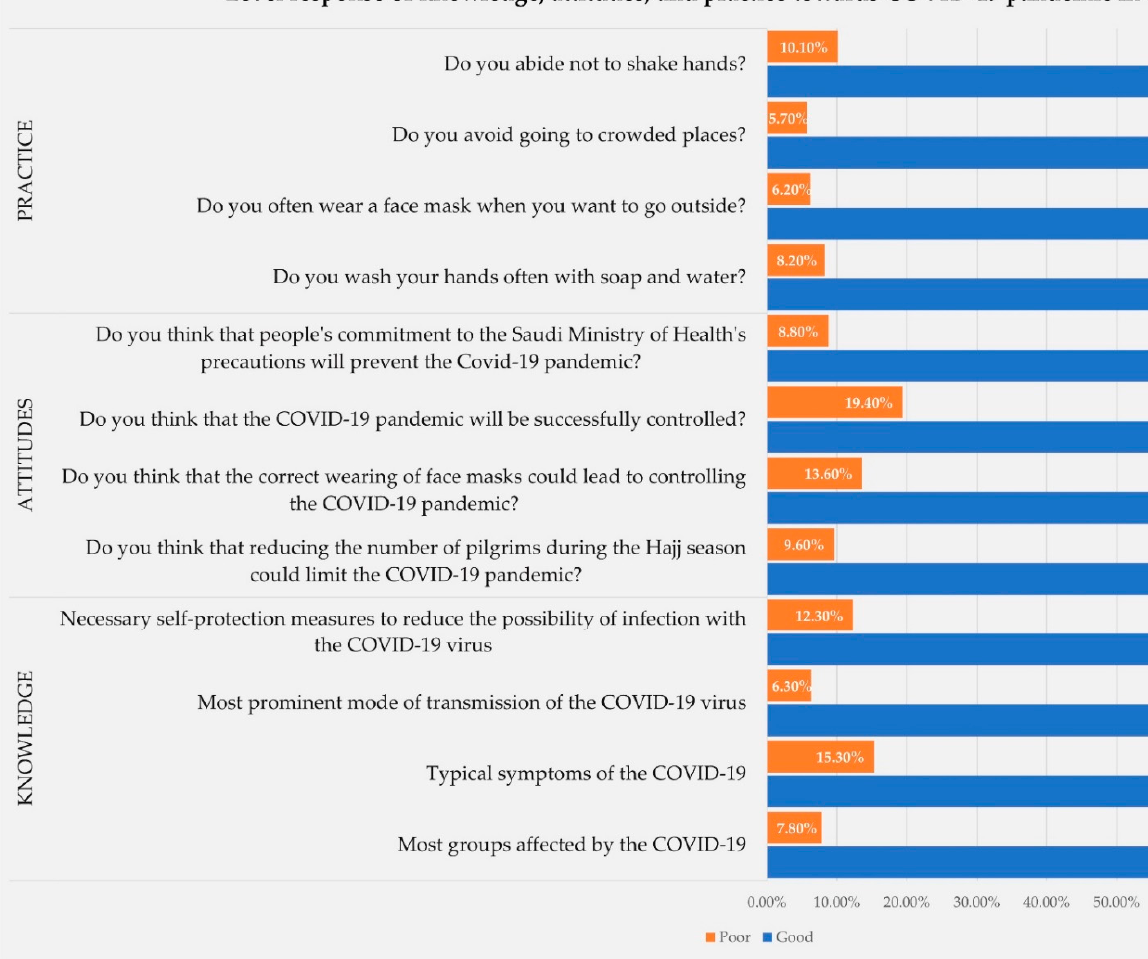
Q Figure 2. The level response of knowledge, attitudes, and practice towards COVID-19 pandemic in Saudi 1